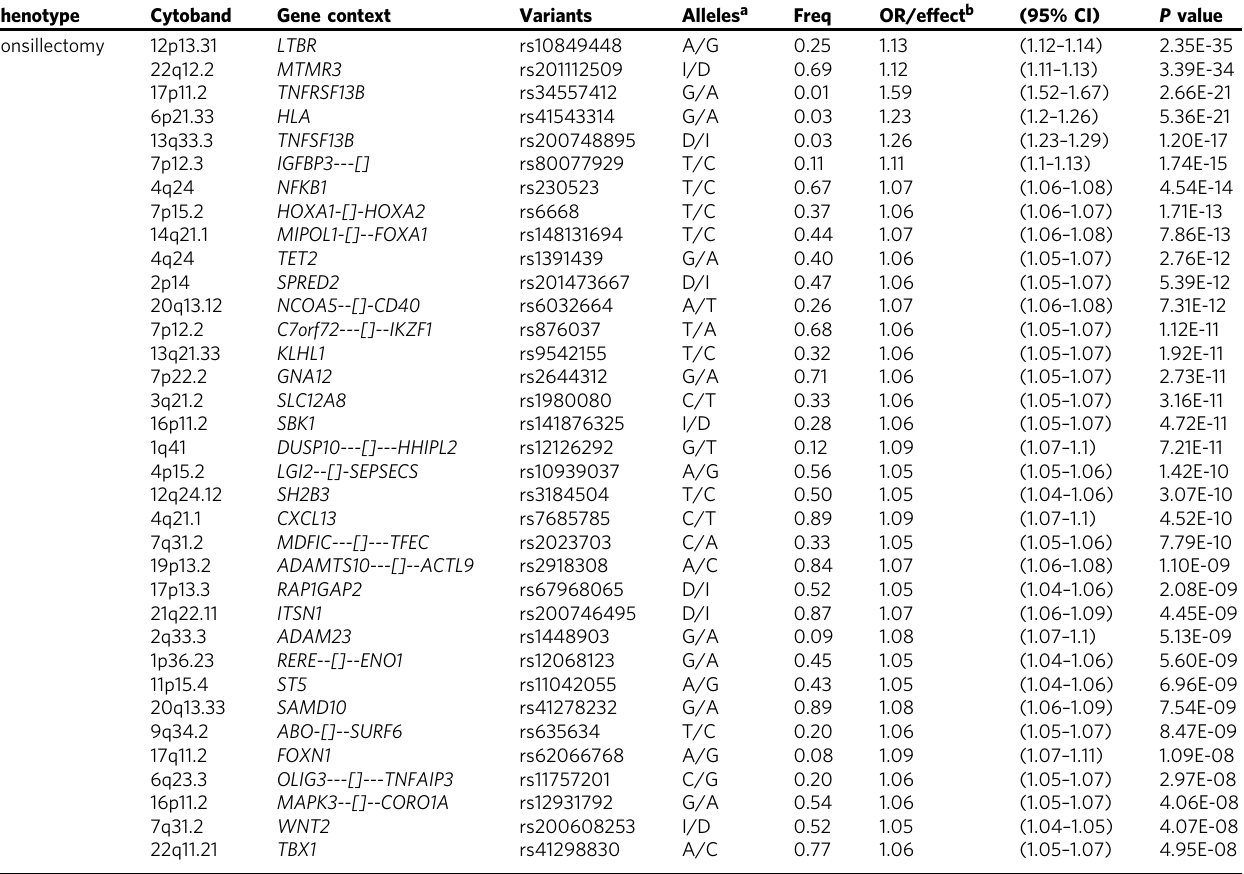
Table 3 Genome-wide signi fi cant associations for each disease part 2